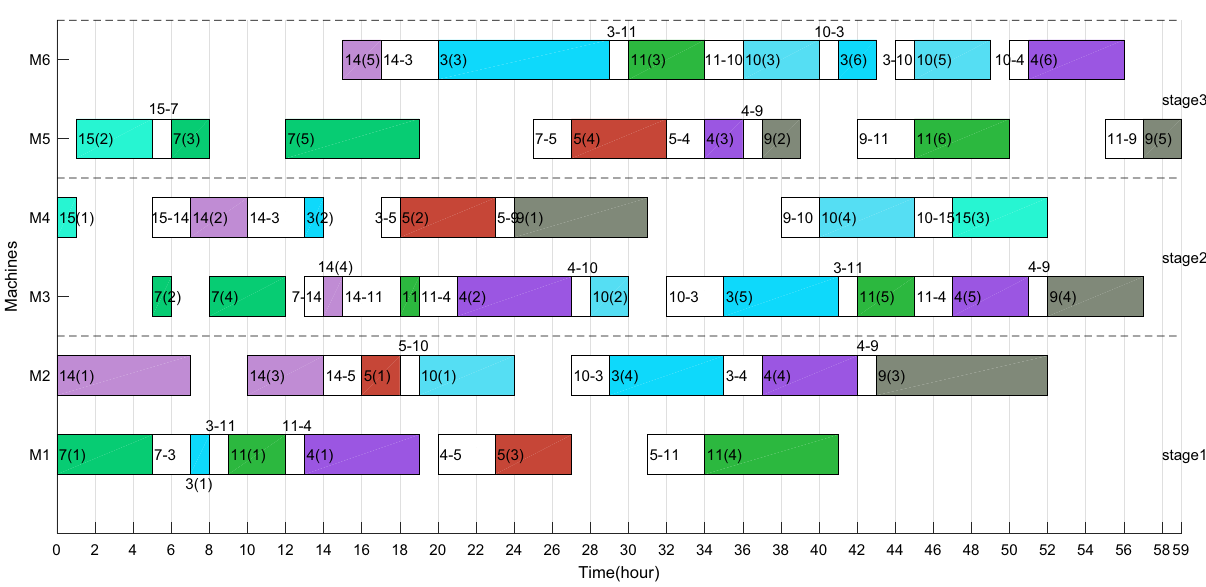
Figure 19. The Gantt chart of instance f2j15s3r1 in factory1 without considering TOU